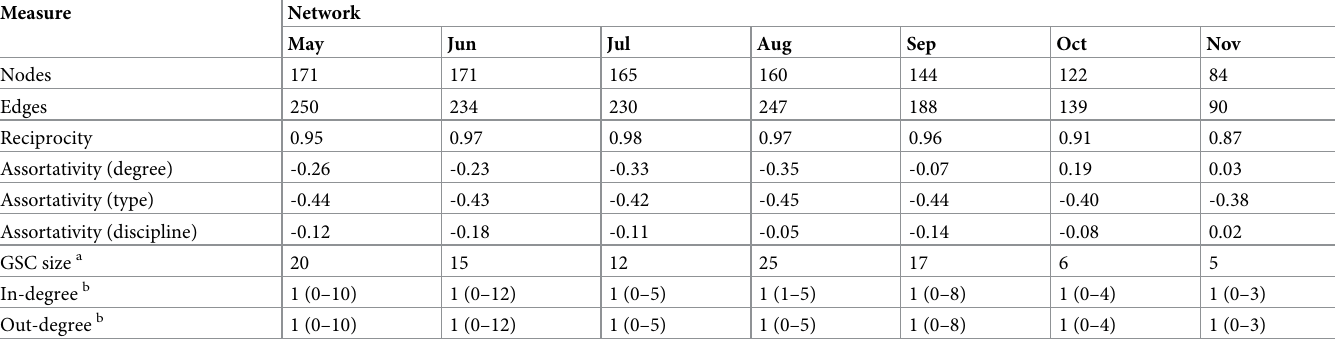
Table 2. Descriptive measures calculated for aggregated monthly networks of horse movements between May and November